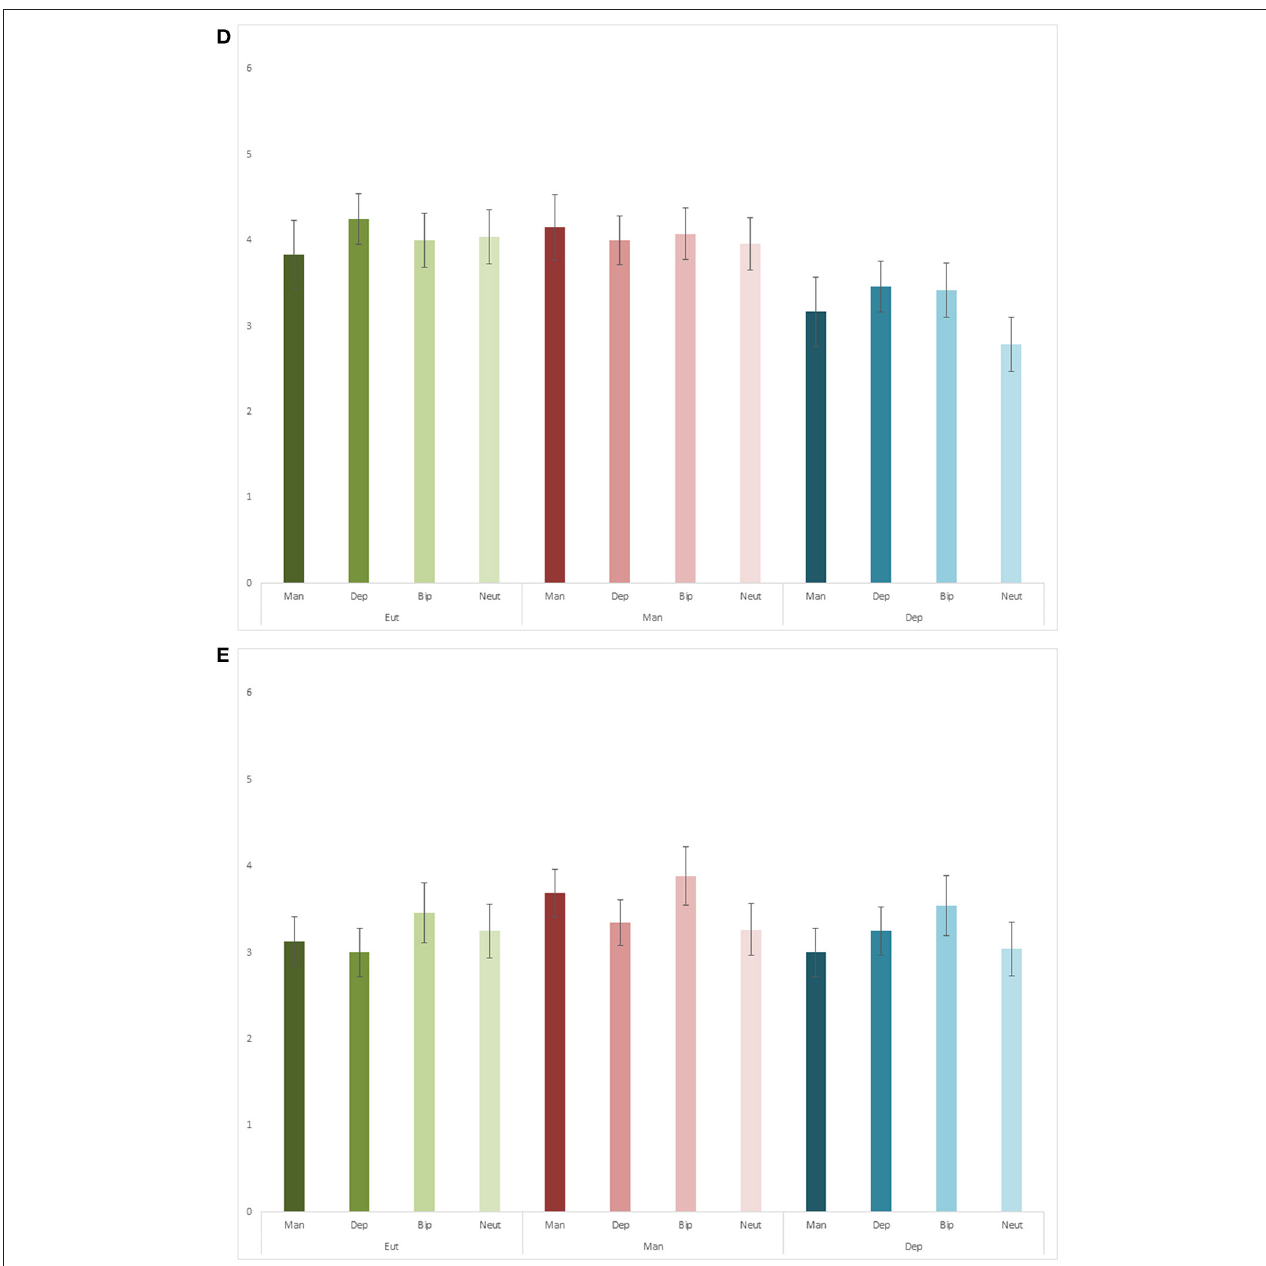
FIGURE 3 | Time (A) , perceptual (B) , thought and emotion (C) , time integration (D) and place detail (E) scores.